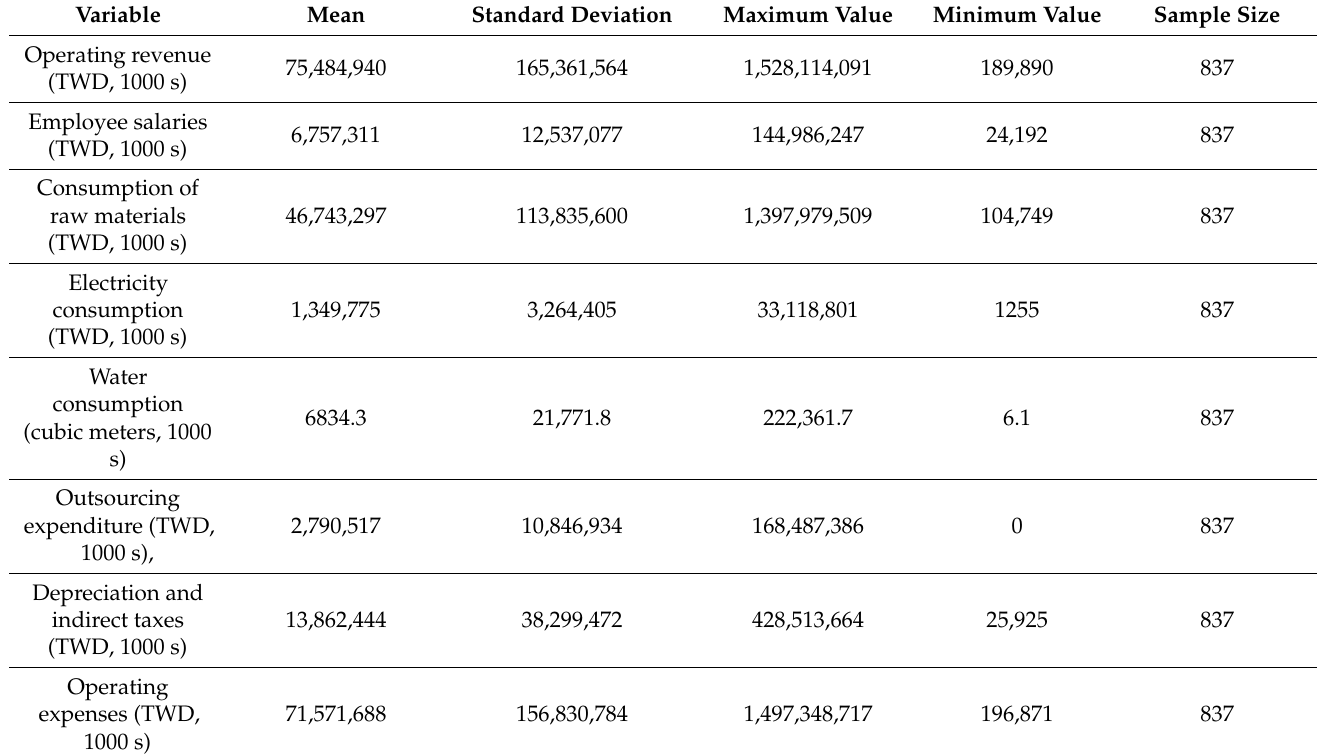
Table 7. Basic Sample